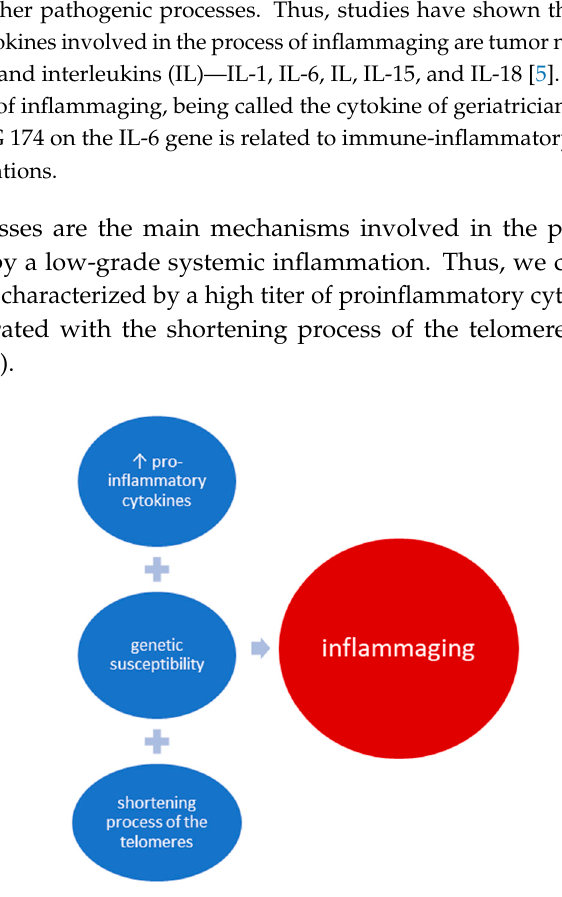
Figure 6. Modifications related to anti-inflammatory and proinflammatory cytokines in the process of inflammaging. Aging is associated with the presence of a low-grade proinflammatory status that maintains all other pathogenic processes. Thus, studies have shown that the most important proinflammatory cytokines involved in the process of inflammaging are tumor necrosis factor α (TNF α ), interferon γ (IFN γ ), and interleukins (IL)—IL-1, IL-6, IL, IL-15, and IL-18 [5]. IL-6 can be considered a predictive marker of inflammaging, being called the cytokine of geriatricians. The polymorphisms in the promoter C/G 174 on the IL-6 gene is related to immune-inflammatory responses and affects serum IL-6 concentrations.